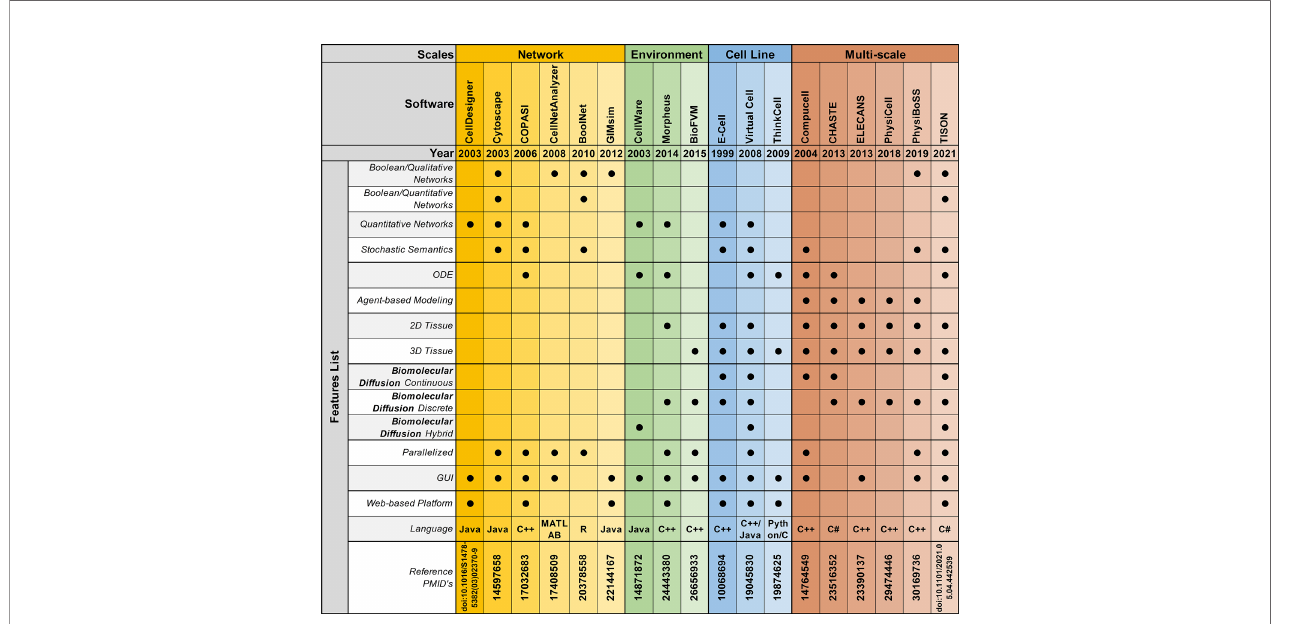
FIGURE 3 | Feature-by-feature comparison of networks, environments, cell lines, and multi-scale modeling software in chronological